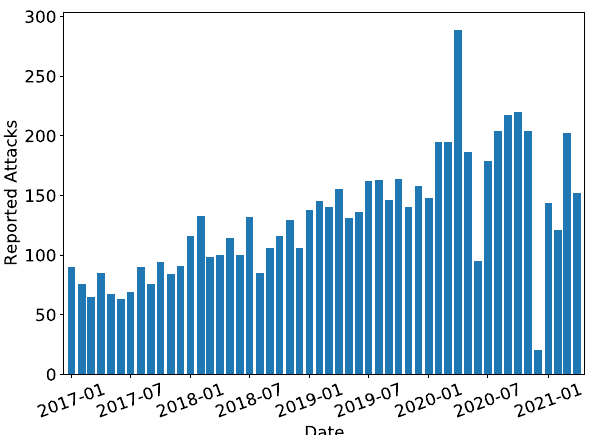
Figure 5. Number of monthly incidents in the filtered dataset. Records that did not produce a single coherent SVO-triple (subject–verb–object) for the attack were omitted to produce a consistent knowledge graph. It should be noted that the time of occurrence of an event (a triple) in the dataset can be wrongly recorded or reported long after the attack. Also, it is notable from the number of attacks that the reporting is not uniform and some months are much less populated than others, likely resulting from human error or